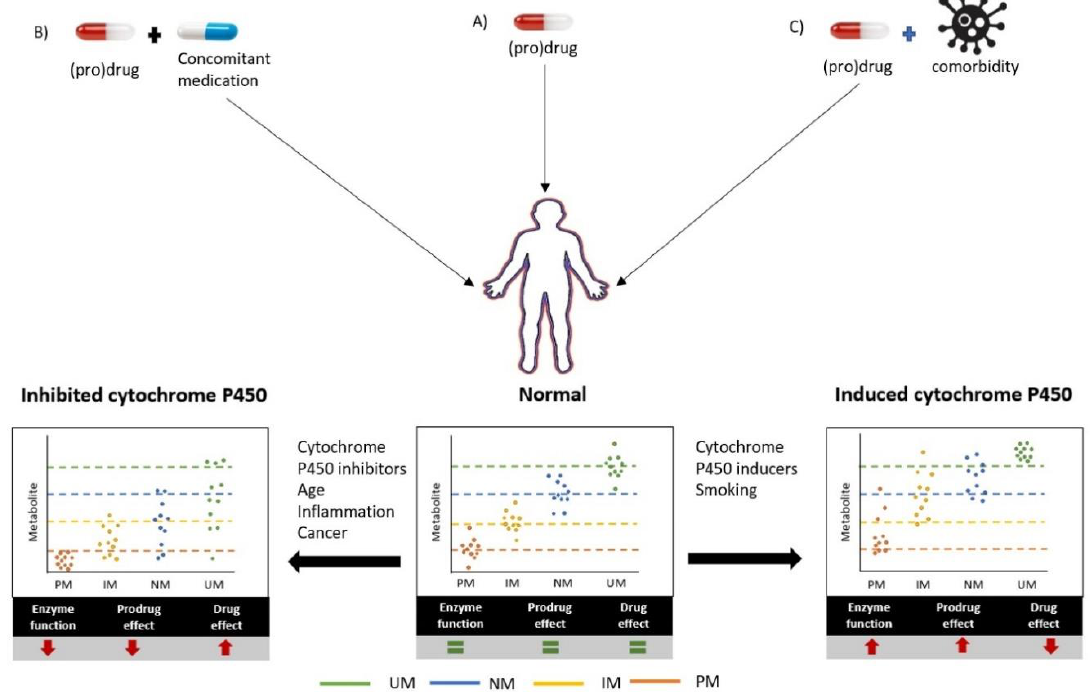
Figure 2. Cytochrome P450-mediated drug metabolism can be inhibited or induced by the presence of co-medication and / or comorbidities, for which the magnitude of the changes depends on the host’s genotype. The metabolite concentrations in blood are plotted for the genotype-based predicted phenotypes (UM, NM, IM, and PM). This is presented for the normal situation ( A ) and for scenarios in which ( B ) CYP450 activity is inhibited by concomitant medication or ( C ) induced by a comorbidity. The resulting effects on drug efficacy are opposing for drugs and prodrugs. UM = ultra-rapid metabolizer, NM = normal metabolizer, IM = intermediate metabolizer, PM = poor metabolizer.